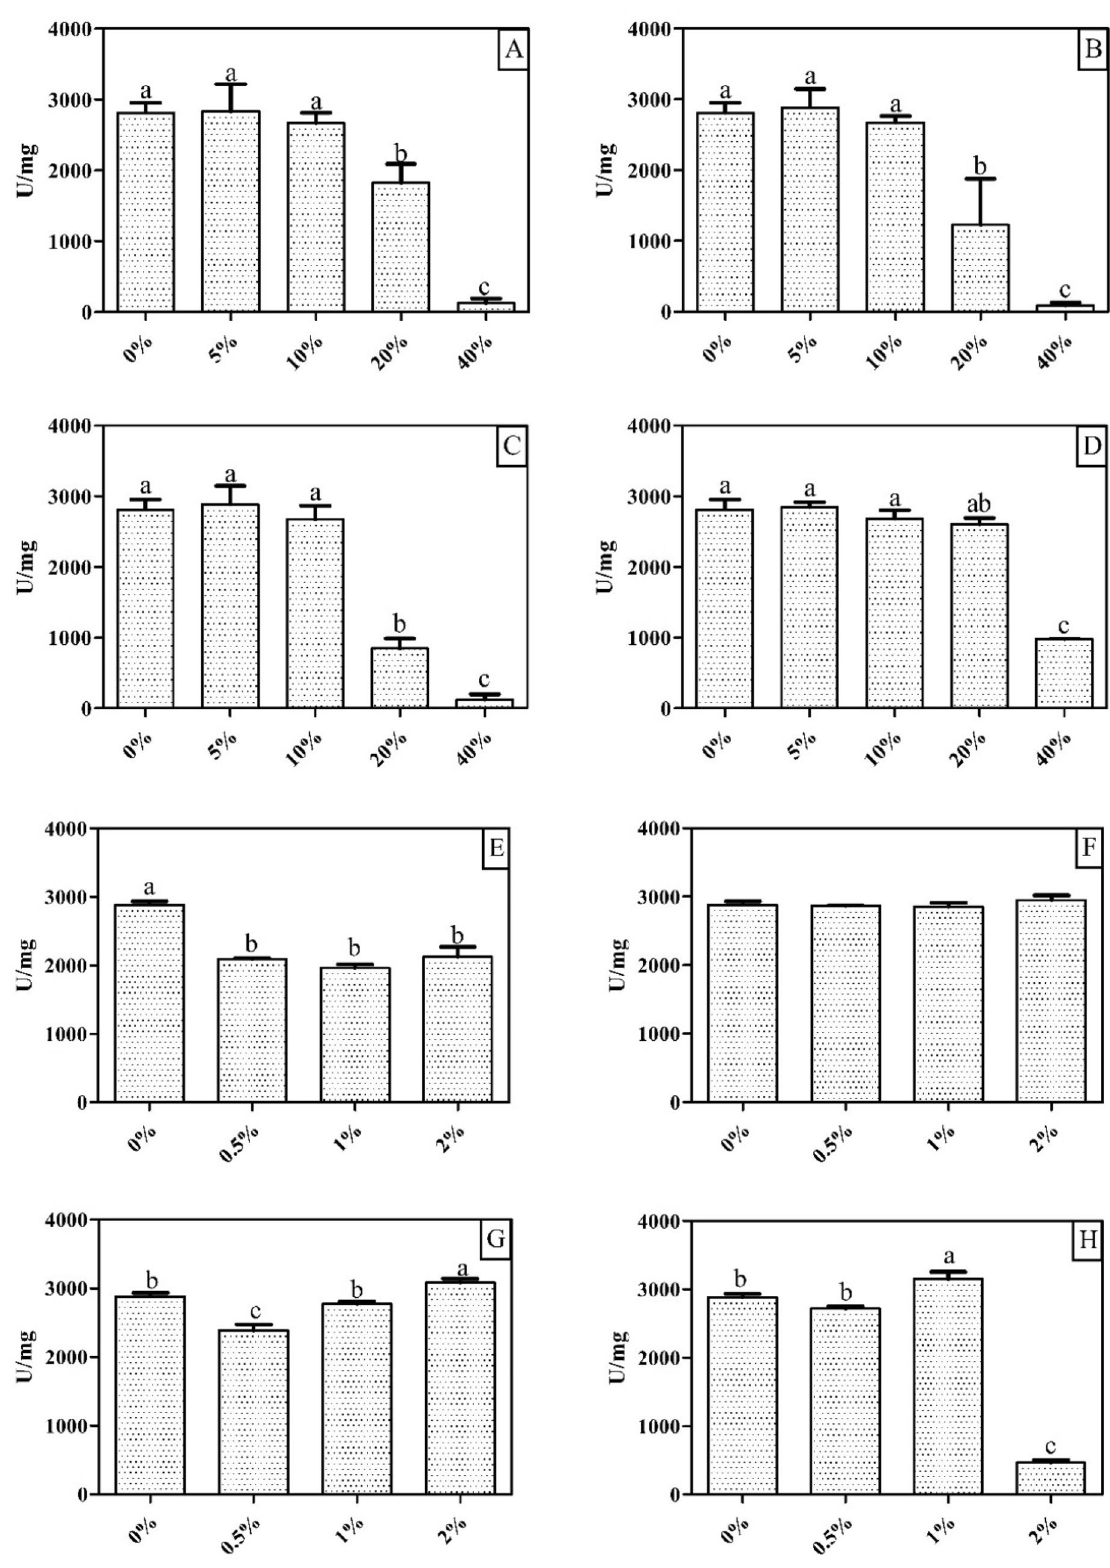
Figure 12. Effect of organic solvents and detergents on XylR activity. ( A ) Methanol; ( B ) Ethanol; ( C ) Propanol; ( D ) Dimethyl Sulfoxide (DMSO); ( E ) Triton X-114; ( F ) Triton X-100; ( G ) Tween20; ( H ) Tween80. The lowercase letters (a, b, c … i) indicate significant differences between each condition tested in the experiment according to the ANOVA and Tukey’s test at 5% probability. Values are presented as the mean ± standard